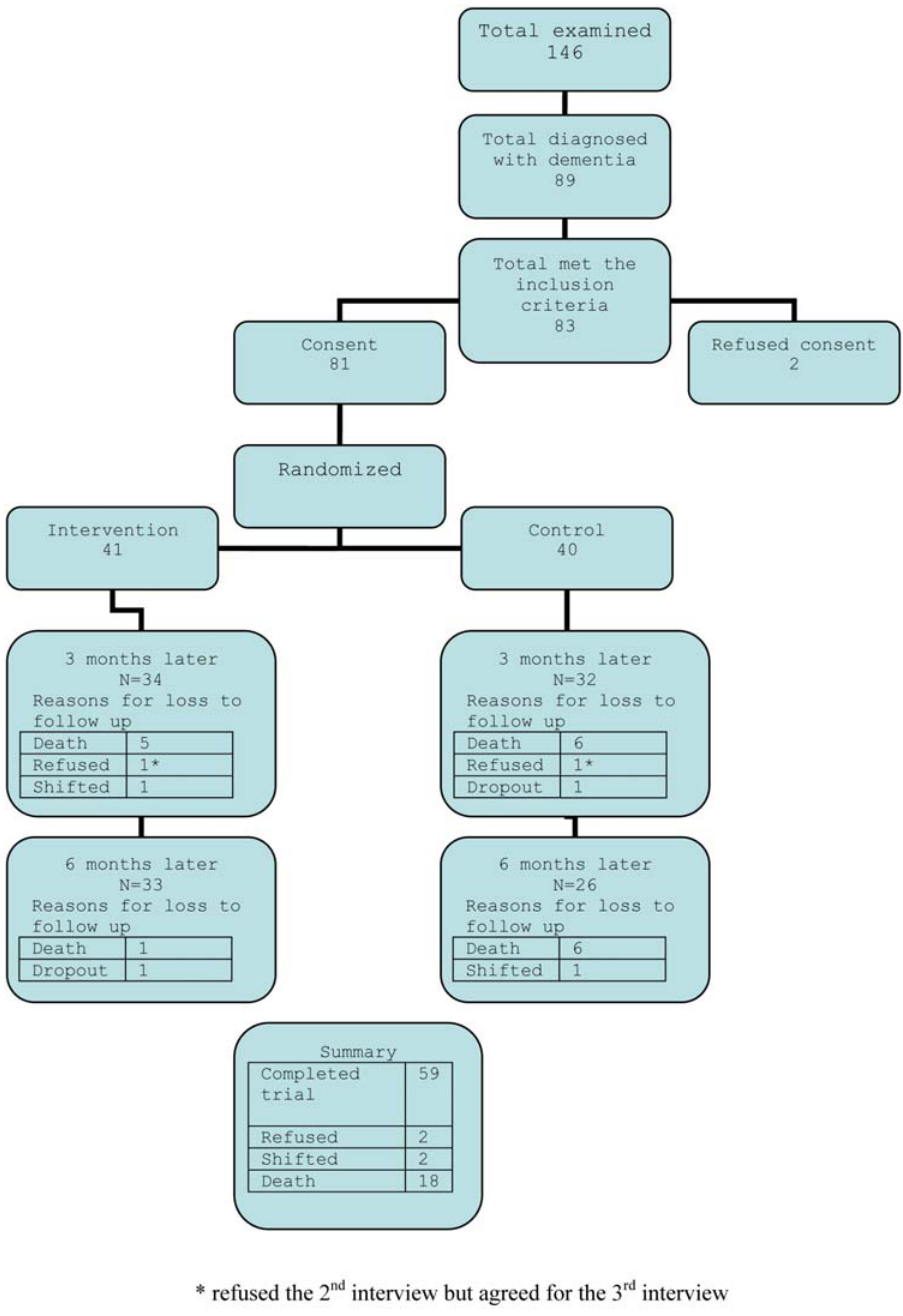
Figure 1. Dementia Trial Flow Chart